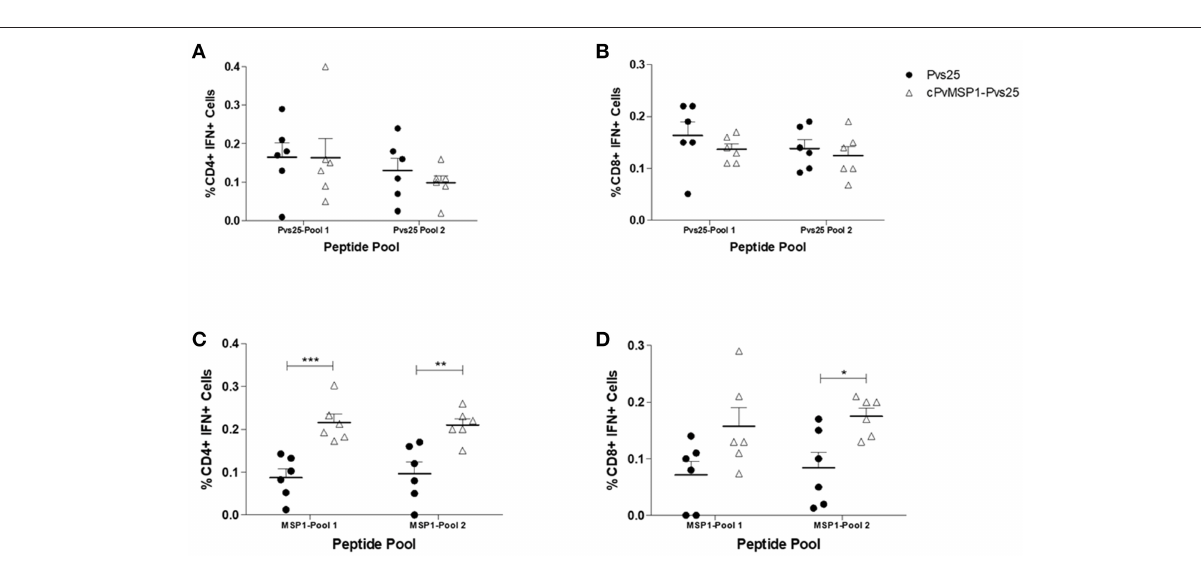
FIGURE 6 | IFN- γ production by CD4 + and CD8 + T cells following stimulation with Pvs25 and cPvMSP1 peptide pools. Splenocytes obtained from CB6F1/J mice immunized with either Pvs25 (closed circles, n = 6) or cPvMSP1-Pvs25 (open triangles, n = 6) 5 days after the final immunization were stimulated with peptide pools representing either MSP1 or Pvs25 at 2 µ g/ml for 2h. Production of interferon- γ in response to stimulation with Pvs25 peptide pools by (A) CD4 + T cells and (B) CD8 + T cells in response to stimulation with cPvMSP1 peptide pools by (C) CD4 + and (D) CD8 + T cells are shown. Statistical analysis was conducted using unpaired t -tests. Statistically significant differences are denoted by * p < 0.05, ** p < 0.01, and *** p <